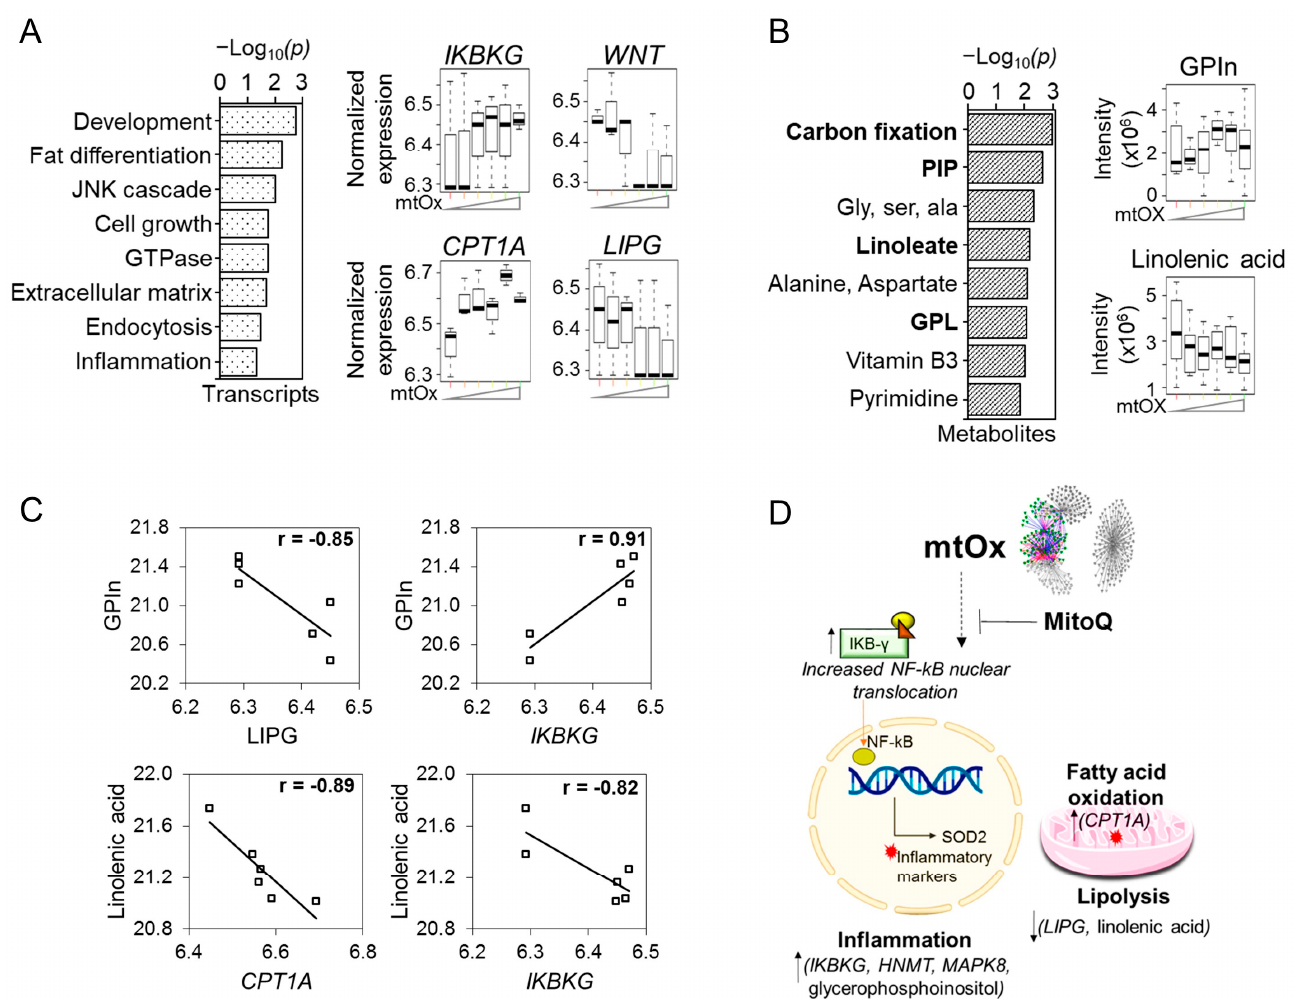
Figure 3. Community 2a: mitochondrial oxidative stress subnetwork associated with signaling markers for in fl ammation, lipid and fa tt y acid metabolism. Pathway enrichment analysis of genes and metabolites associated with mitochondrial oxidative stress (mtOx) subnetwork was studied. ( A ) Top pathways enriched with mtOx-dependent genes at p < 0.05, represented as − log 10 P. Expression of individual genes associated with mtOx from these enriched pathways presented as boxplots in- clude genes involved in in fl ammation and NF- κ B activation—IKBKG; in neuroprotection—WNT1; fa tt y acid oxidation—CPT1A and lipid metabolism—LIPG. ( B ) Metabolite-enriched lipid metabo- lism pathways such as carbon fi xation, phosphotidyl inositol phosphate, linoleate, glycerophospho-